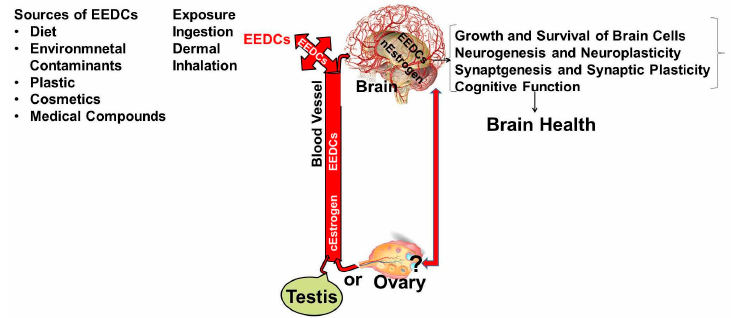
Figure 1. A schematic representation showing how circulatory (c) estrogen produced by ovary or testis, neural (n) estrogen (produced by aromatization of testosterone to 17 β estradiol (E2) by neuronal or glial aromatase in the brain) and estrogenic Endocrine Disruptors (EEDs) entering into the blood circulation from ingestion, inhalation or dermal exposure may interact in the brain and their impact on brain health. Neural estradiol and ovarian estradiol feedback remains to be ascertained. Int. J. Mol. Sci. 2016 , 17 , 2086